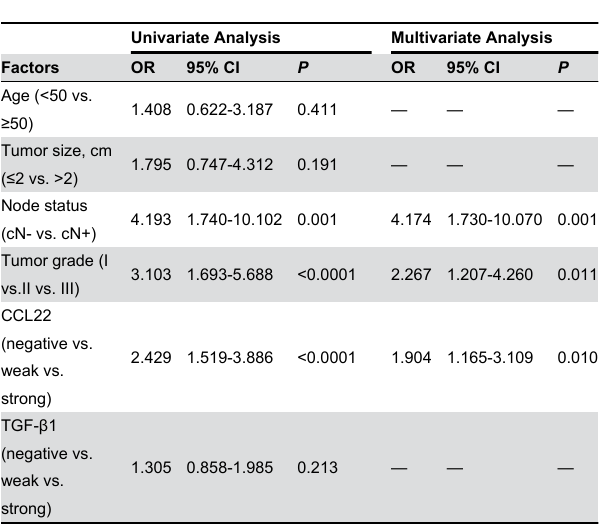
Table 6. Univariate and multivariate analyses (logistic regression) of pathological features and cytokines for PFS in